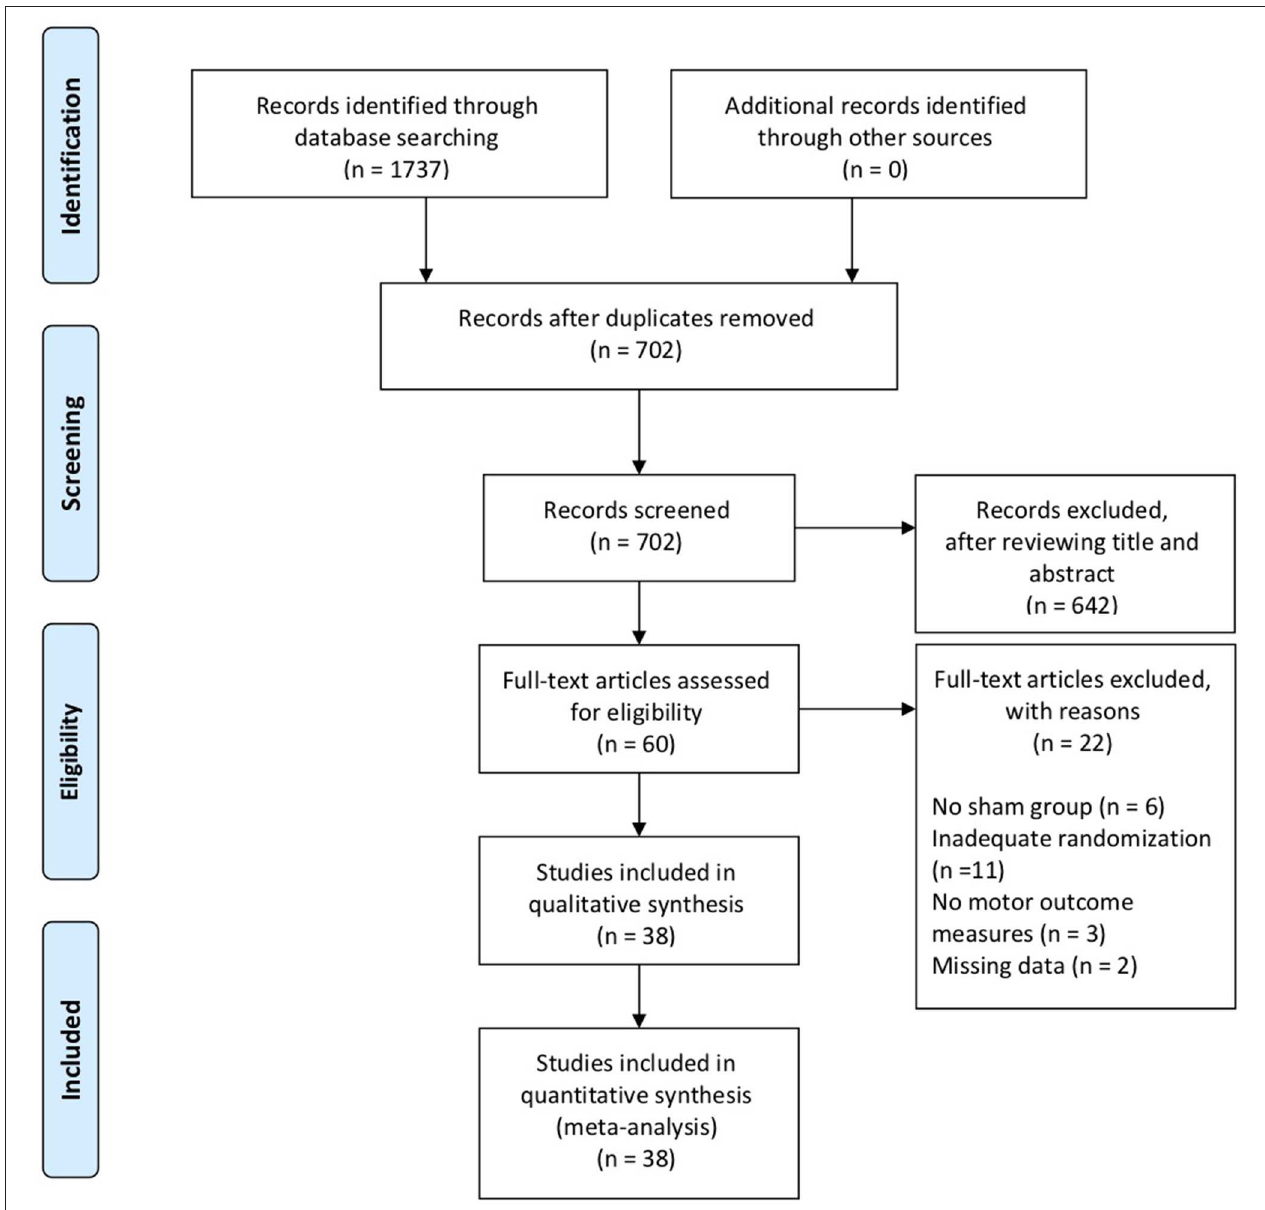
FIGURE 1 | PRISMA flow